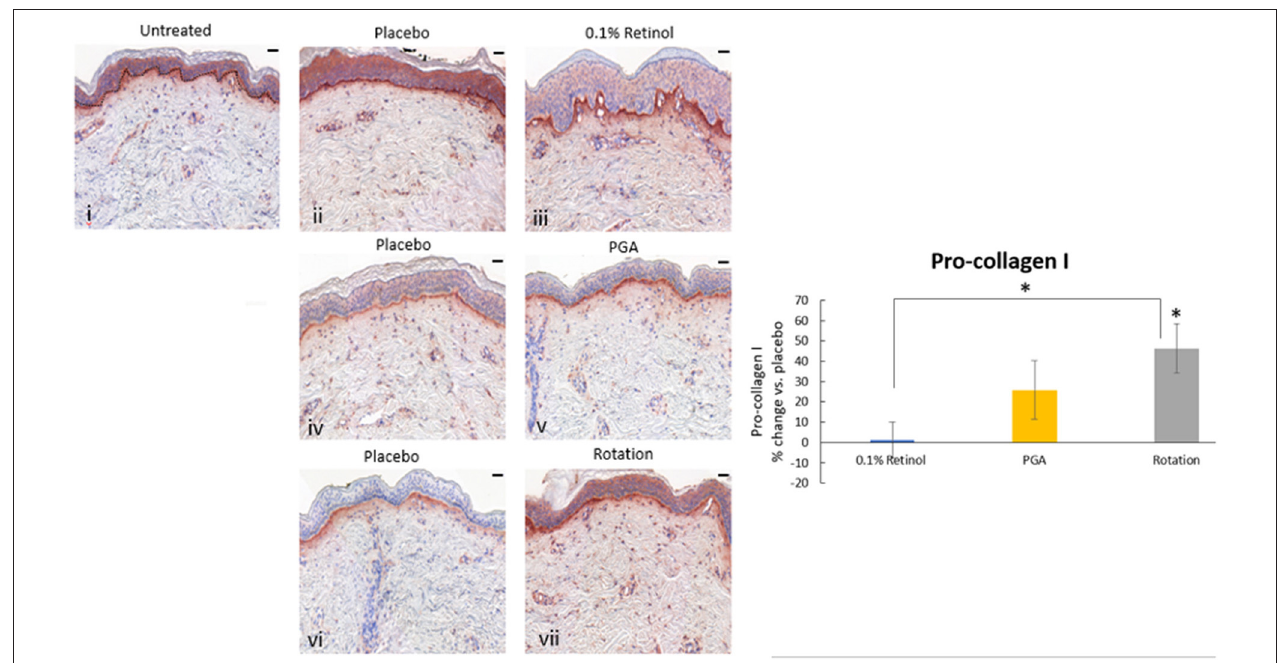
FIGURE 9 | Immunohistology of skin biopsies. Volunteers ( n = 32) received application of either 0.1% retinol formulation for 4 weeks or weekly rotation of 1% phytol/4% glycolic acid (PGA) formula with 0.1% retinol formula. Biopsy samples were taken at the end of the 4-week period. An analysis of pro-Collagen I in in vivo skin samples using pro-collagen I antibody was performed. Pro-collagen I production increased significantly in rotational treatment and was better than retinol alone. i: untreated, ii: placebo for retinol, iii: retinol, iv: placebo for PGA, v: PGA, vi: placebo for vii, and vii: rotation of iii and v. Scale bar = 50 µ m. *Means p < 0.05 or statistically significant